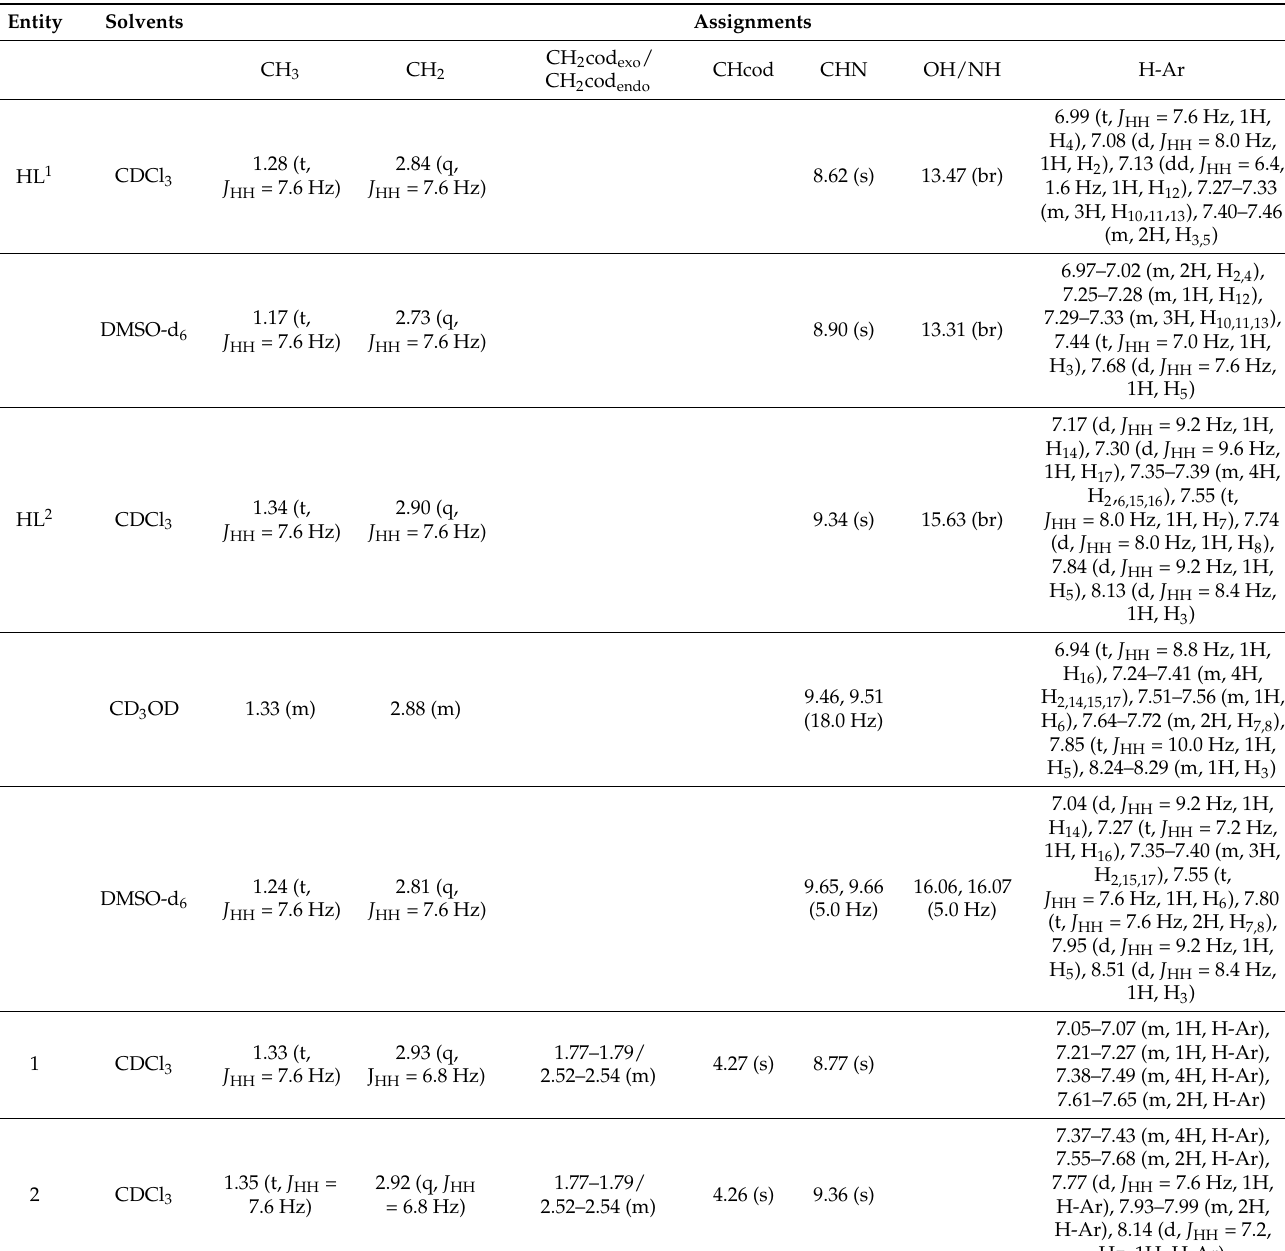
Table 1. 1 H NMR (400 MHz) data for the Schiff bases and complexes at 20 ◦